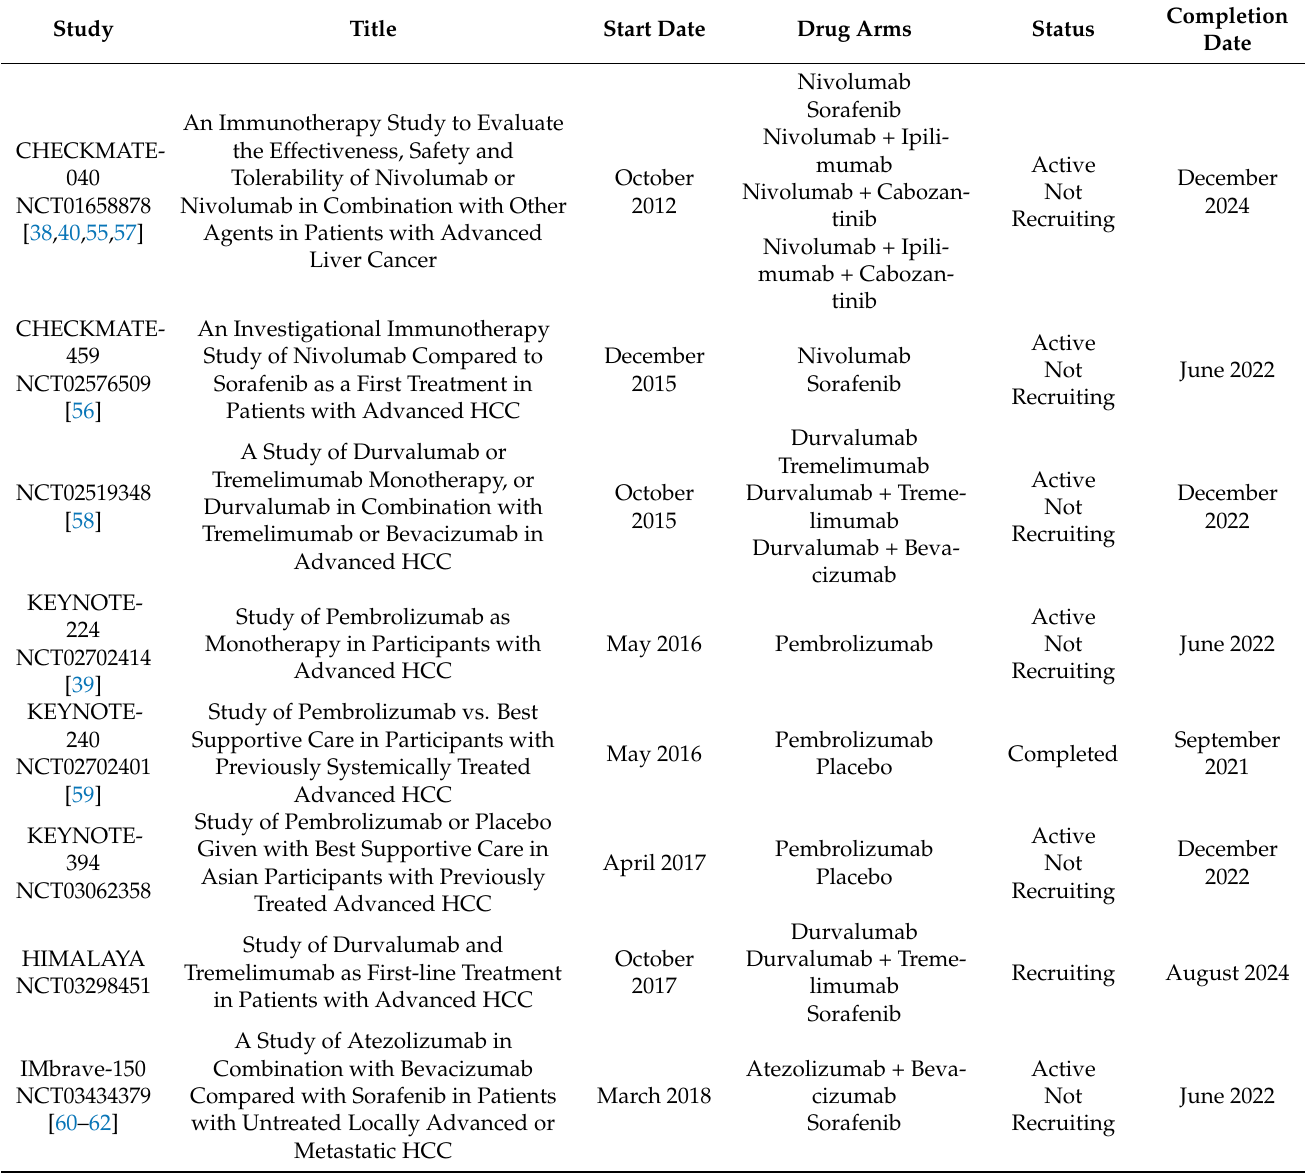
Table 2. Completed/ongoing relevant immune checkpoint inhibitor studies for advanced